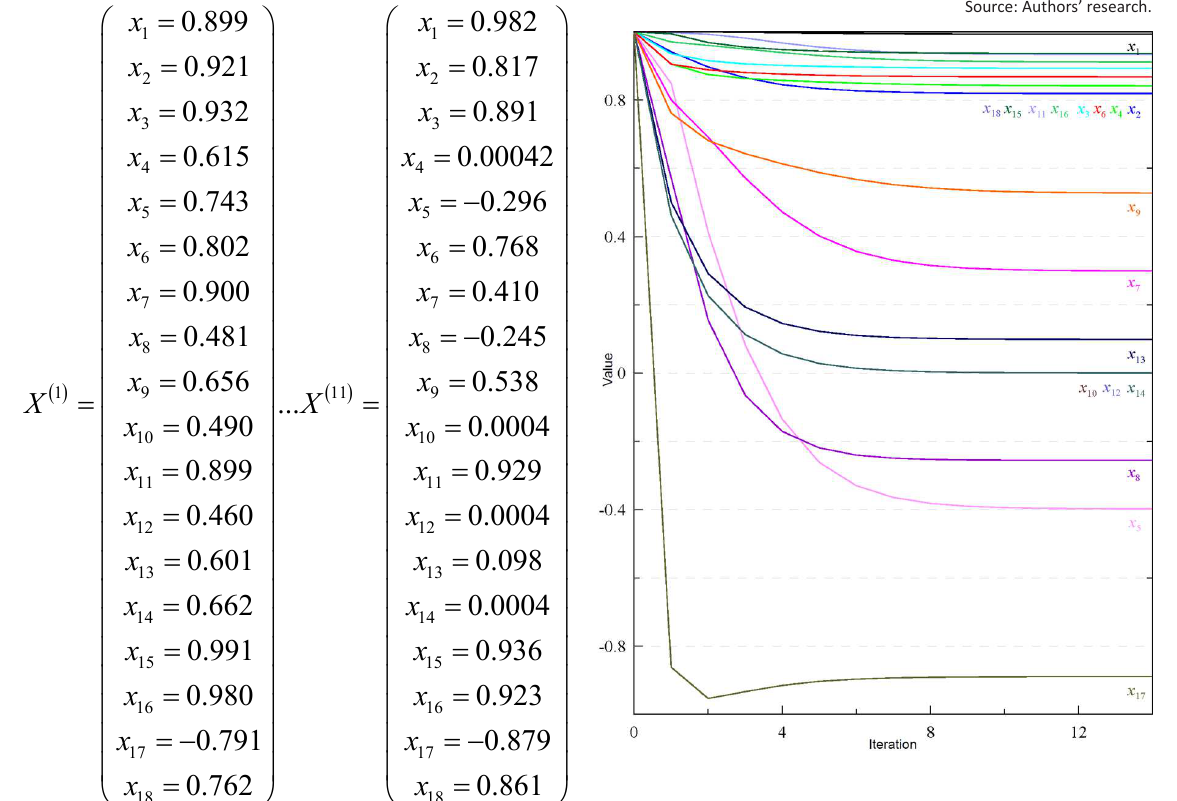
Figure 2. Results of the 1-14